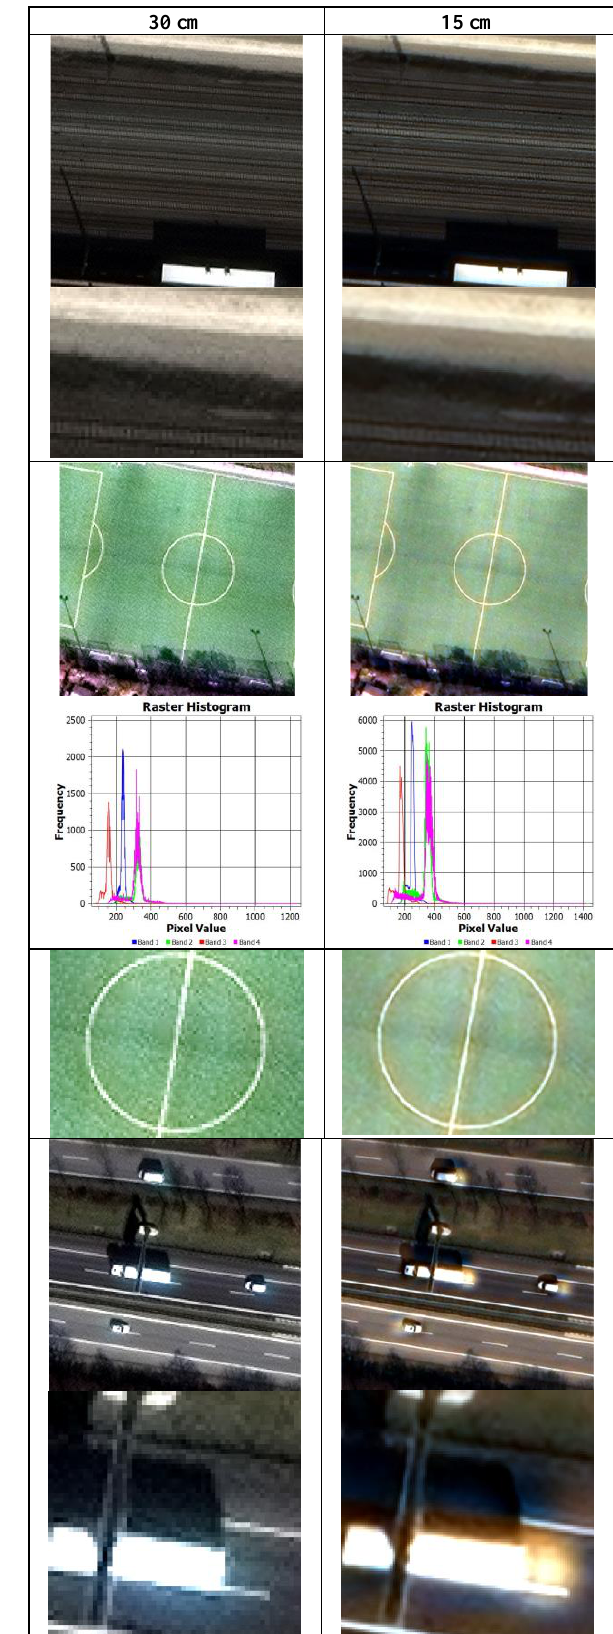
Figure 10. MAXAR 30 cm (left) and 15 cm (right) image parts over railway, soccer field and a road in